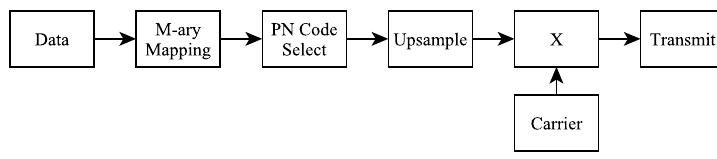
Figure 1. Block Diagram for Signal Generation.